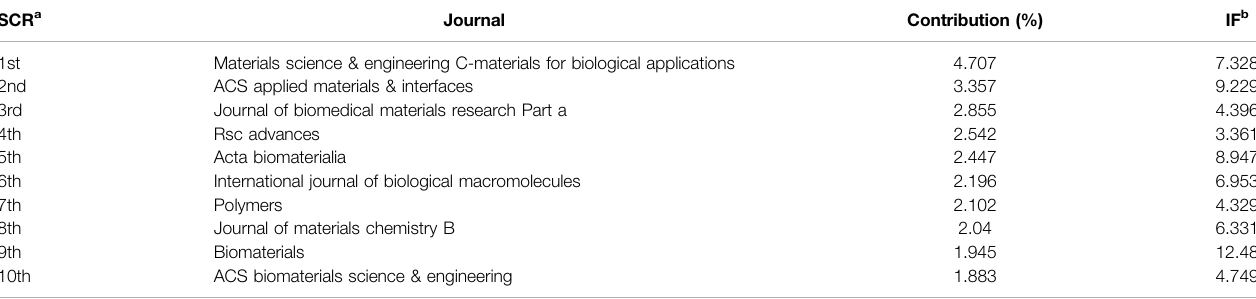
TABLE 1 | The top 10 journals publishing articles on the electroactive biomaterials used in